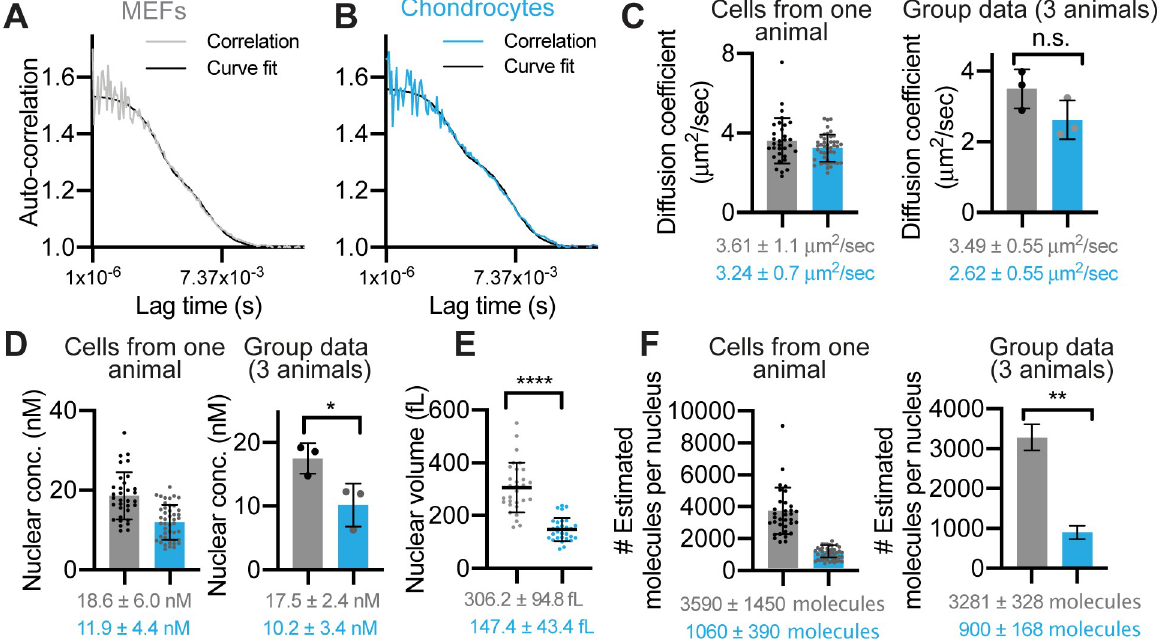
Fig 5. Quantitative analysis of molecular behaviour of Venus::BMAL1 measured by FCS. A, B), FCS of Venus::BMAL1 in unsynchronised MEFs (grey) and chondrocytes (blue). Representative autocorrelation curves were fitted to a one-component diffusion model with a triplet state. C, D) Quantitative analysis of Venus::BMAL1 FCS data. Scatter plots presented in pairs, first, as measurements of cells taken from an individual representative animal, followed by group data: mean averages across three different animals. Mean ± SD; n = 40 cells per mouse, from 3 mice. C) Diffusion coefficient (3.49 ± 0.55 μ m 2 /s in MEFs and 2.62 ± 0.55 μ m 2 /s in chondrocytes). D) Molecular concentration (17.5 ± 2.47 nM in MEFs and 10.2 ± 3.45 nM in chondrocytes). E) Mean ± SD nuclear volume measurements for MEF cells (grey, 306 ± 95 fL, n = 30 cells) and chondrocytes (blue, 147 ± 43 fL, n = 30 cells). F) Estimated number of Venus::BMAL1 molecules per nucleus in MEFs and chondrocytes. The calculation of the mean was based on the molecular concentration of Venus::BMAL1 in each cell and the average nuclear volume for that cell type, as calculated in E. In the group data (right), the SD was adjusted by using a formula: Nuclear volumes: Unpaired two- tailed t-test; concentration, diffusion coefficient and molecular number: Paired two-tailed